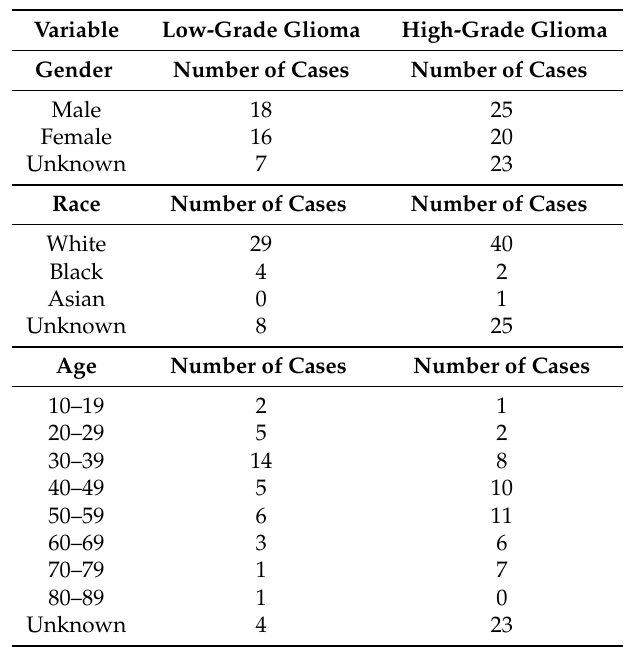
Table 2. Statistical analysis.